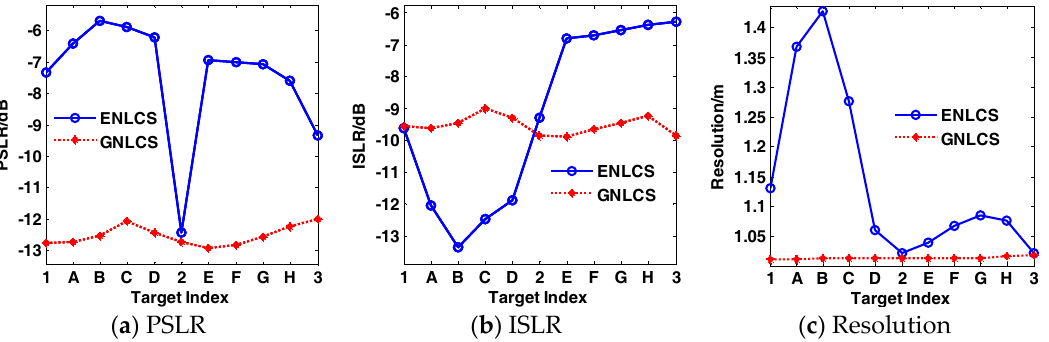
Figure 6. Focusing performances of different algorithms on 11 points marked in Figure 4. The blue solid lines with ‘o’ marker are the results of ENLCSA. The red dash lines with ‘*’ marker are the results of the GNLCSA. ( a – c ) represent the peak side-lobe ratio (PSLR), integrated side-lobe ratio (ISLR) and resolution, respectively.